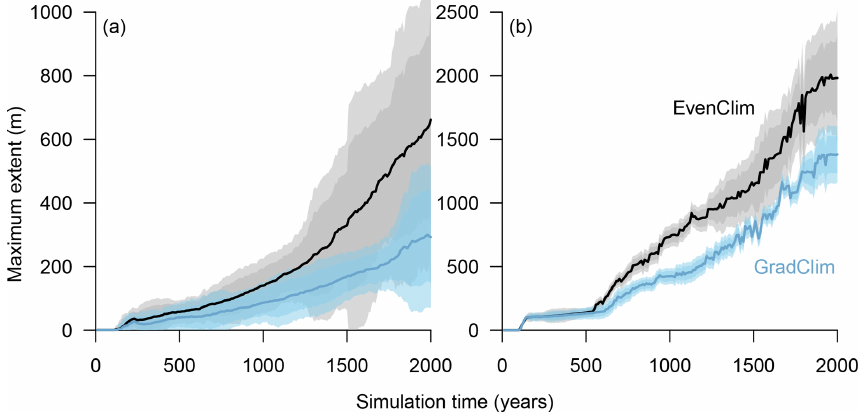
Figure 7. Simulations along a hypothetical transect at the tundra–taiga transition reveal the northward advance of (a) the forest line (mean density falling below 100treesha − 1 ) and (b) treeline (mean density falling below 1treeha − 1 ). Simulations were forced by two contrasting temperature scenarios (homogeneous temperature EvenClim – grey shading – and northward linearly decreasing temperature and precipita- tion GradClim – darker blue shading). Shaded areas give the 99% and 90% confidence intervals around the mean value of 10 simulation